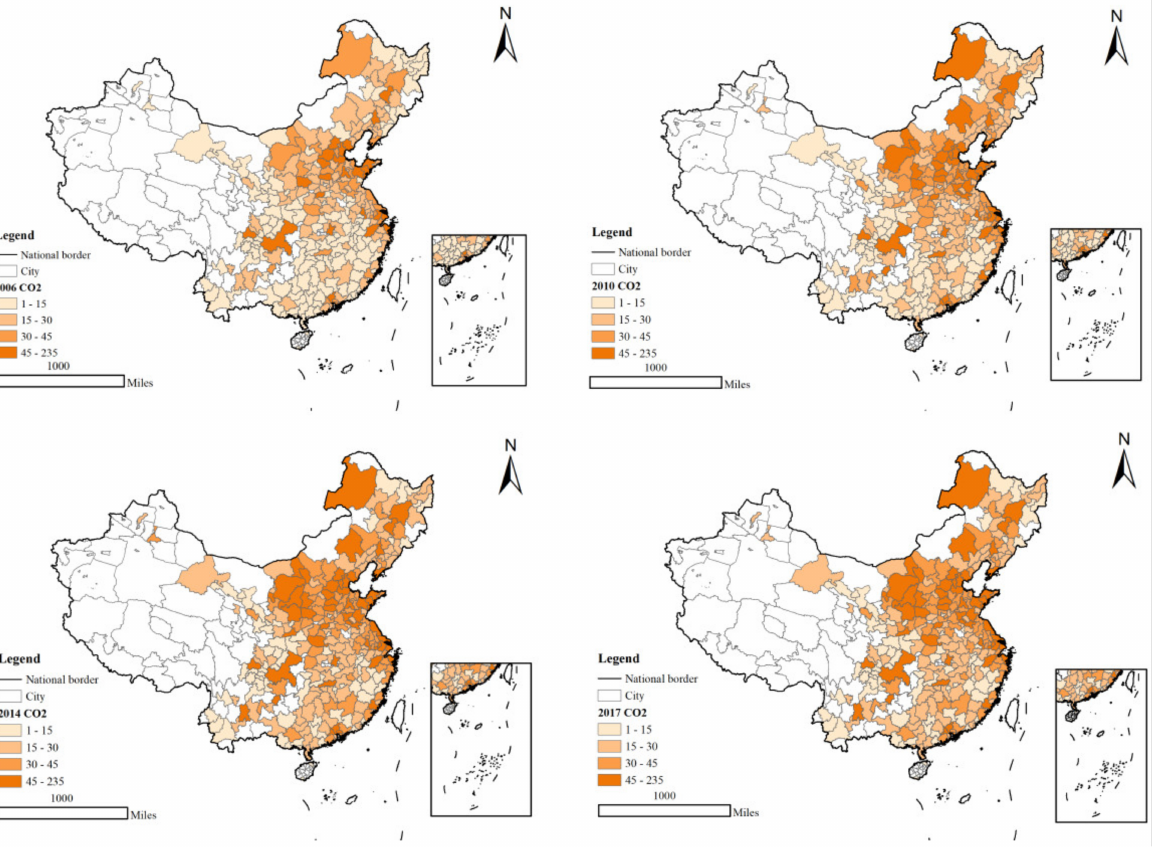
Figure 1. China’s carbon emission trends in 2006, 2010, 2014, and